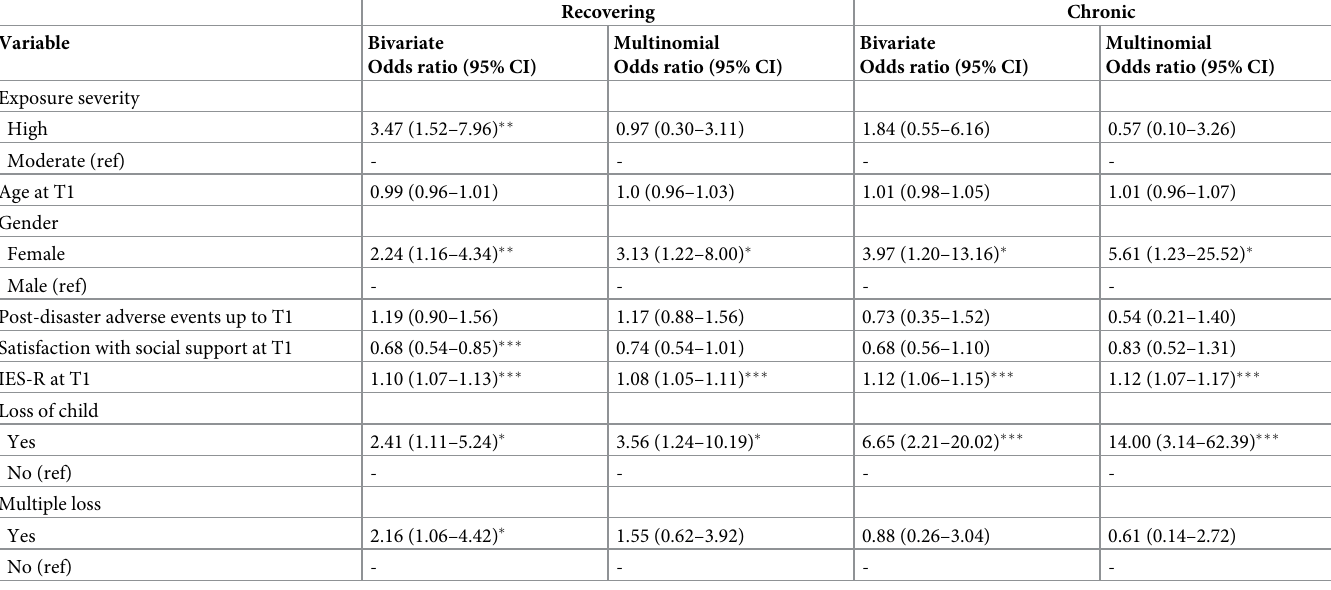
Table 3. Regression analysis of predictors for the prolonged grief trajectories, with the resilient class as the reference